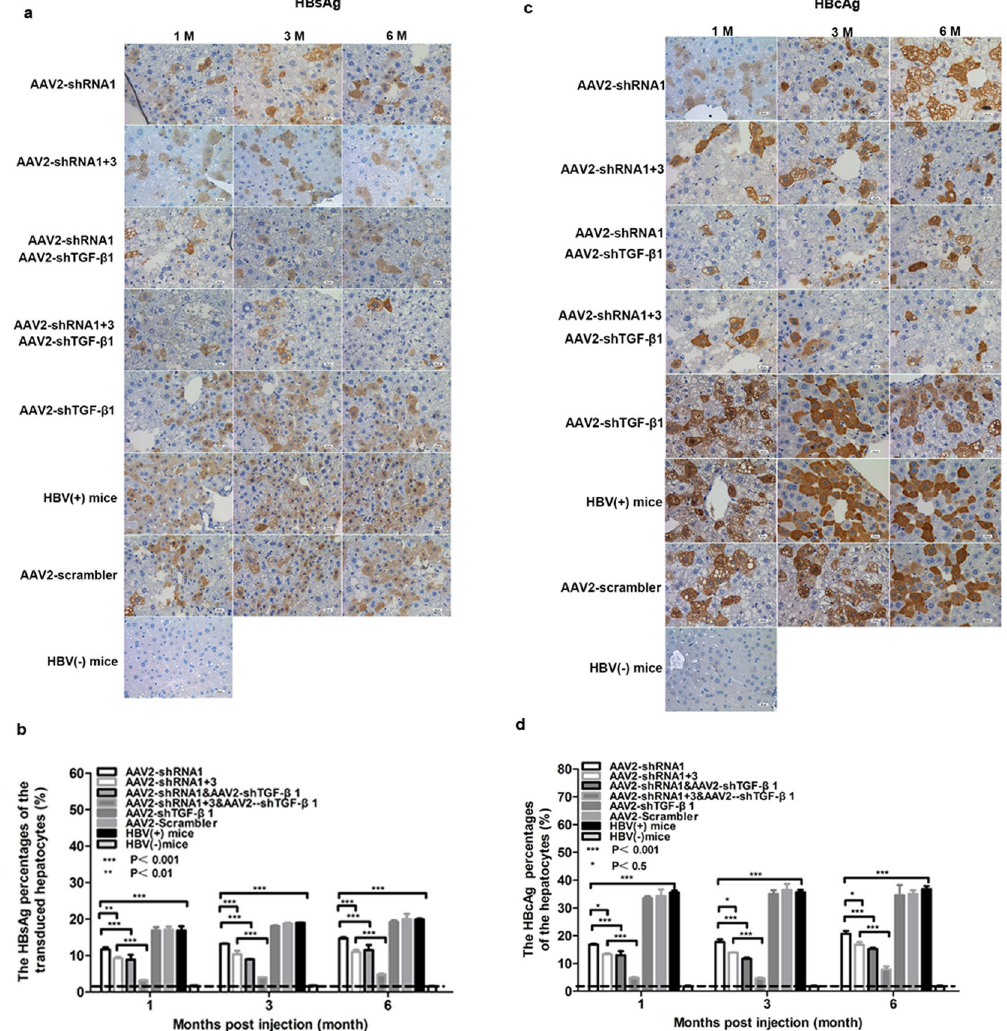
Figure 5. AAV-shRNA treatment decreases HBsAg and HBcAg in hepatocytes of HBV-persistent mice. Serum and liver samples of mice treated with AAV2-shRNA were collected at the indicated time points during a 6 month period. Liver sections were fixed and stained for HBsAg ( a ) and HBcAg ( c ). Ten random fields were selected per slide, and the percentages of HBsAg- ( b ) and HBcAg-positive ( d ) hepatocytes were quantified using Image-Pro Plus. P < 0.05: significant difference, Data represent the mean ±